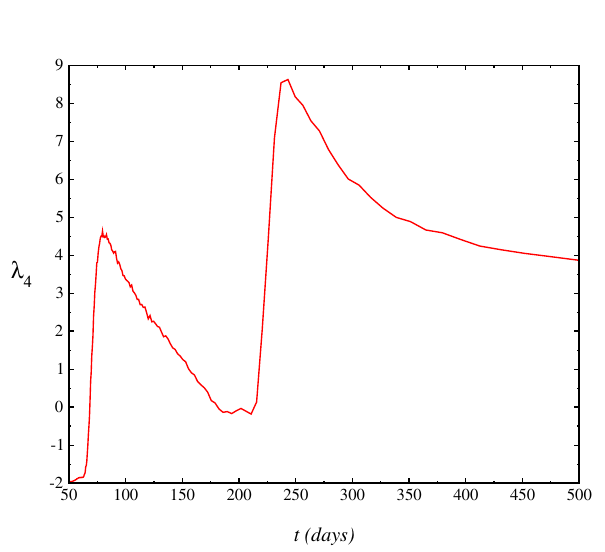
N 2 analogous to the mean-square root deviation of a particle in (cid:31) (cid:30) (cid:31)